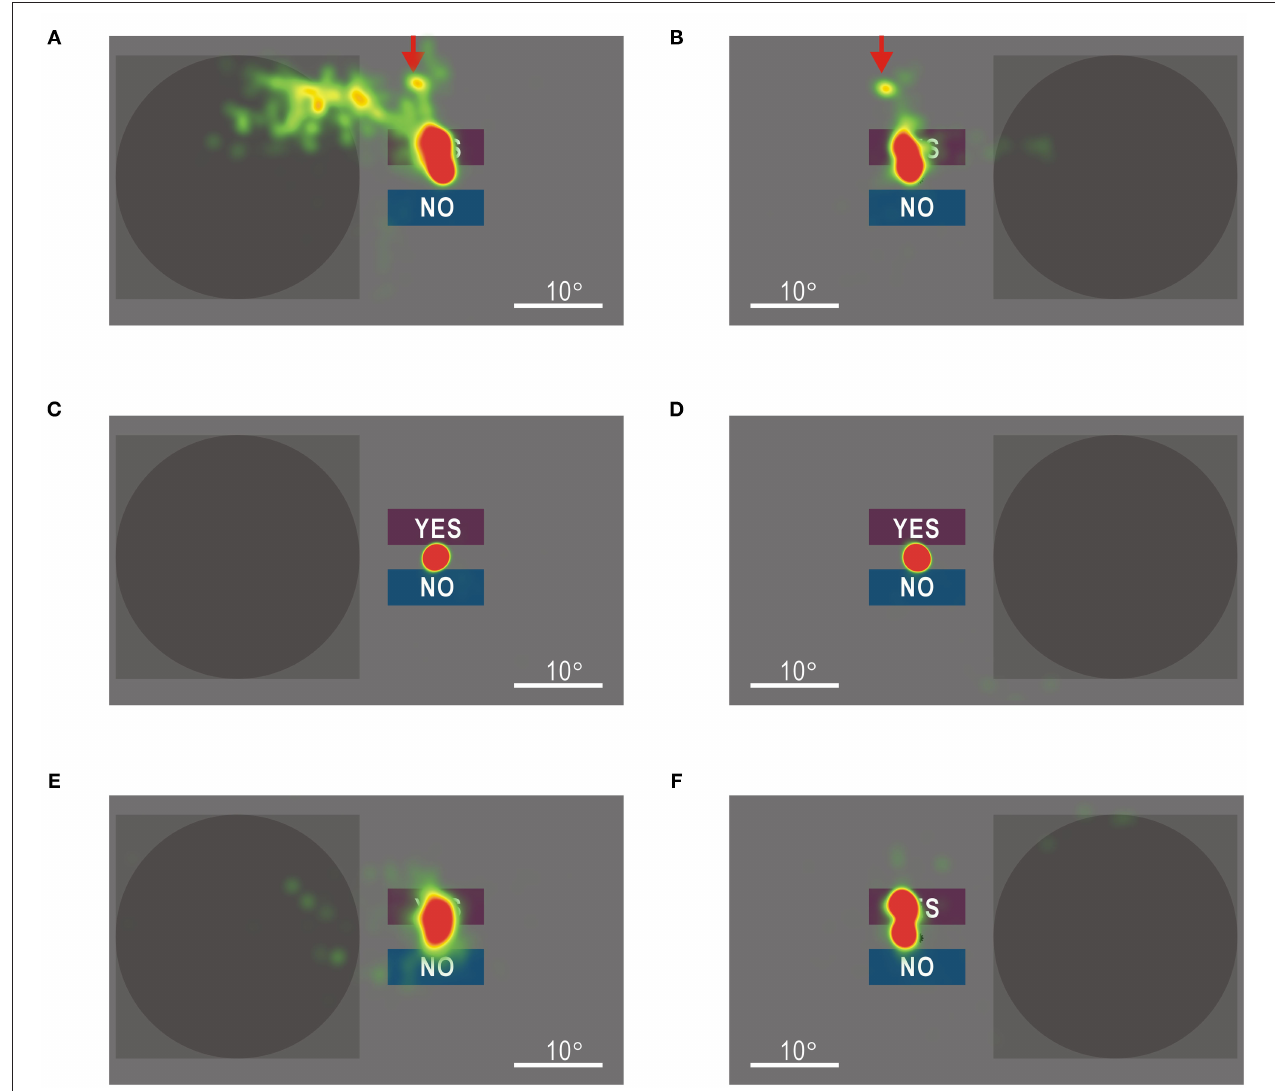
FIGURE 7 | (A) Heat map of gaze shifts of the patient with homonymous hemianopia during the left visual field test without gaze check tasks. Color maps are shown in an arbitrary scale. (B) Gaze shifts of the patient during the right visual field test without gaze check tasks. The gaze shifts to the upper left direction in (A) were also observed (red arrows). (C) Gaze shifts of a control participant during the left visual field test without gaze check tasks. (D) Gaze shifts of the control participant during the right visual field test without gaze check tasks. (E) Gaze shifts of the patient during the left visual field test with gaze check tasks. (F) Gaze shifts of the patient during the right visual field test with gaze check tasks. Gaze shifts in (E) and (F) were more restricted around the fixation point than those in (A) and (B) , respectively.